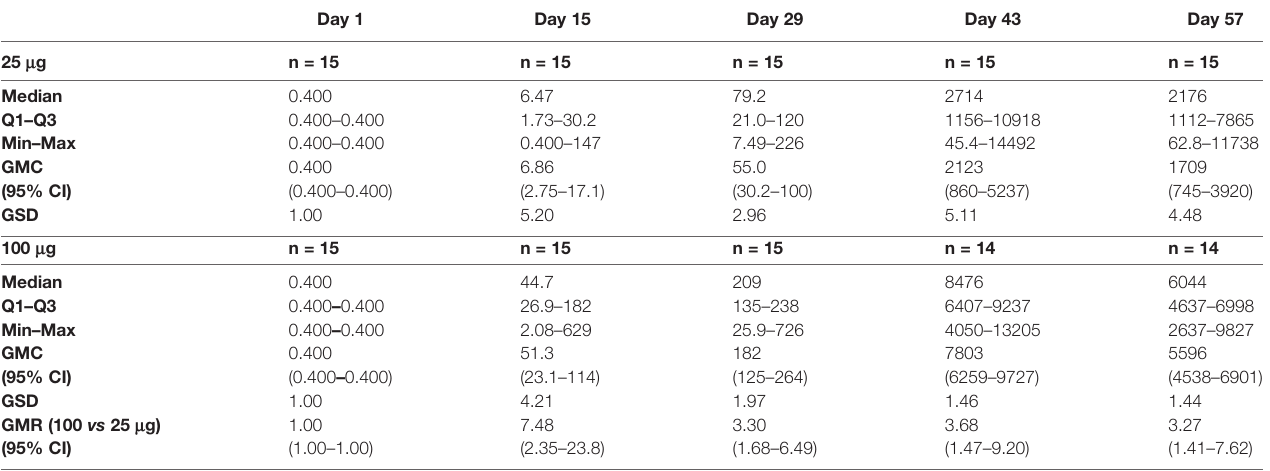
TABLE 1 | ACOV2S summary statistics and GMR, comparing the 100 m g group to the 25 m g